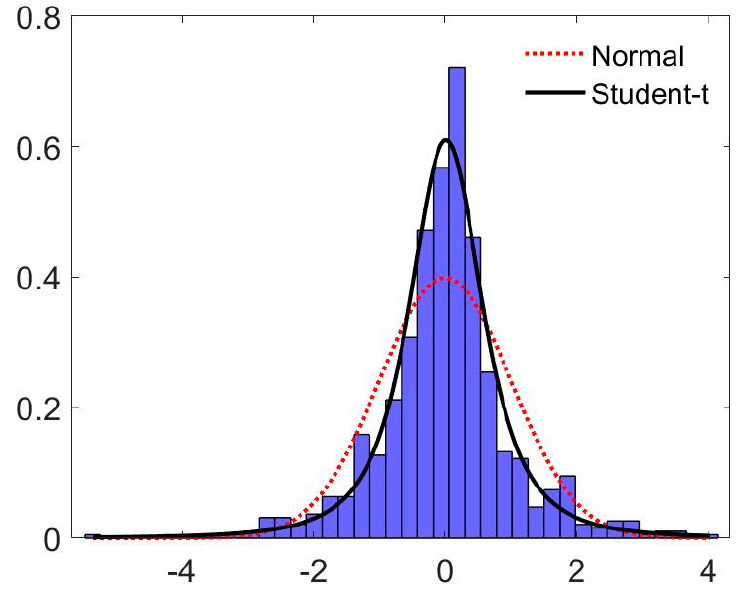
Figure 3. Residuals from homoscedastic model. Note: Density on vertical axis.